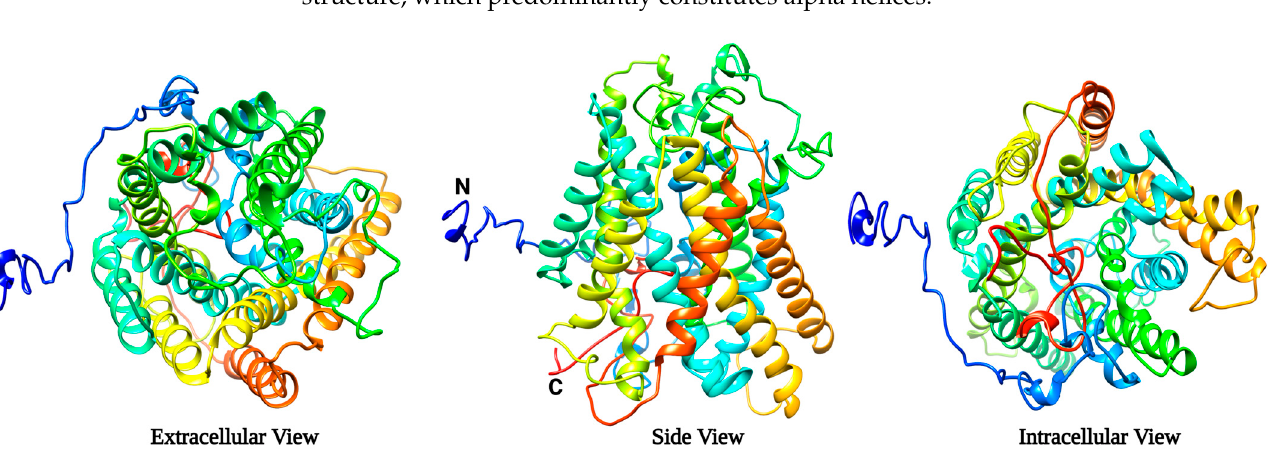
Figure 2. I-TASSER predicted model of Agp2 from different views. Extracellular is the top view from the outside of the lipid bilayer. The side view is from the front looking across the lipid bilayer, N and C denote N- and C-termini, respectively. The intracellular view is from the inside of the cell.